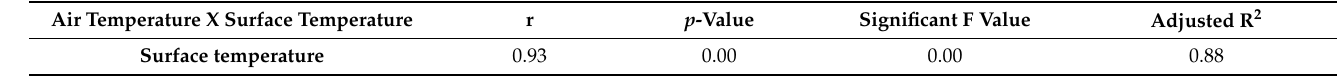
Table 3. Results of the simple regression and ANOVA p -value ( α ≤ 0.05) considering measured air temperature and surface temperature in Presidente Prudente on 10 May 2020.